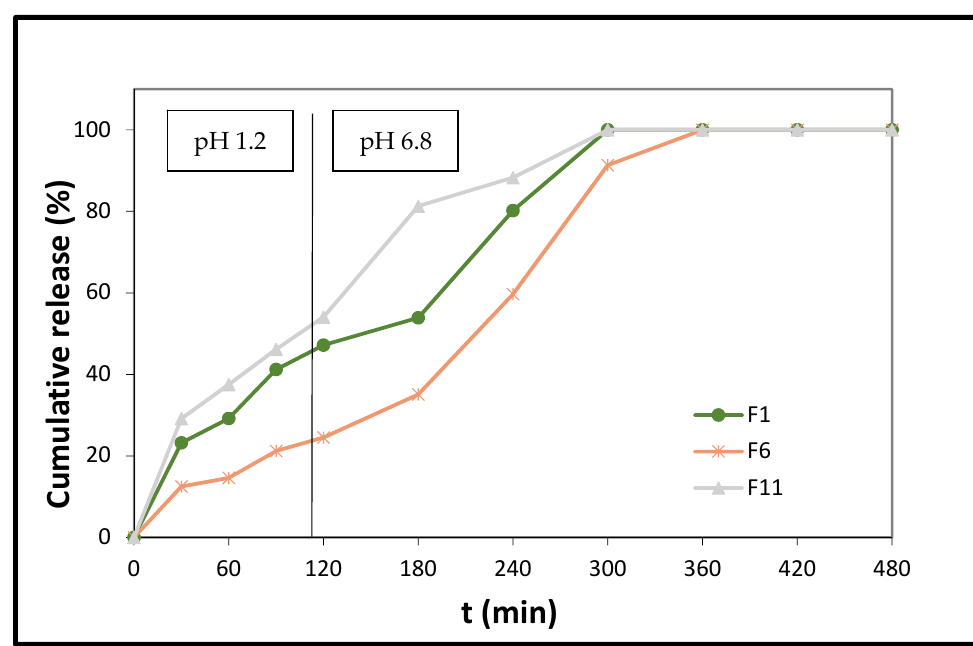
Figure 4. In vitro % release of melatonin from formulations F1, F6, and F11 vs. time. The results represent the mean value (n = 3, SD < 2).